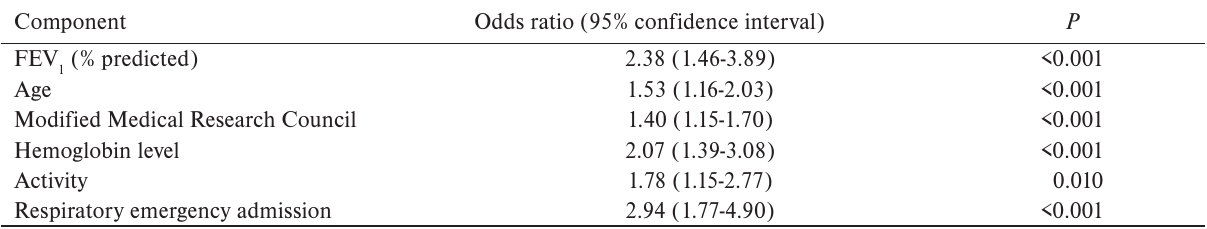
Table 4. Impact of each component score on two-year mortality.